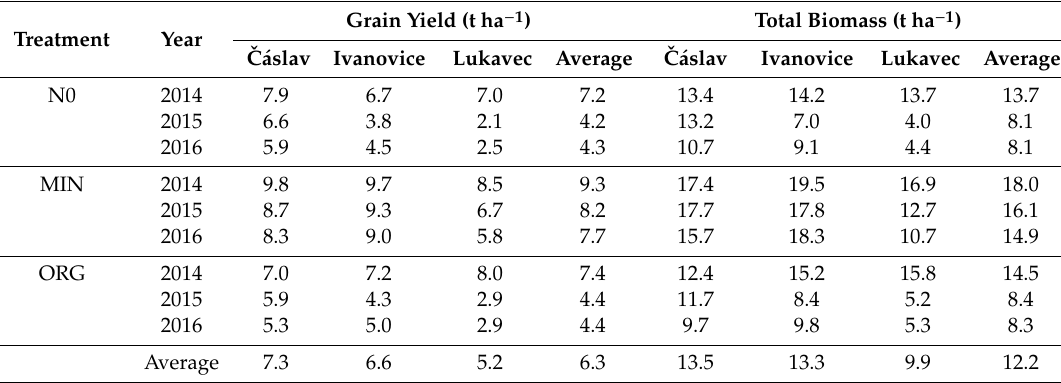
Table 4. Grain and total biomass